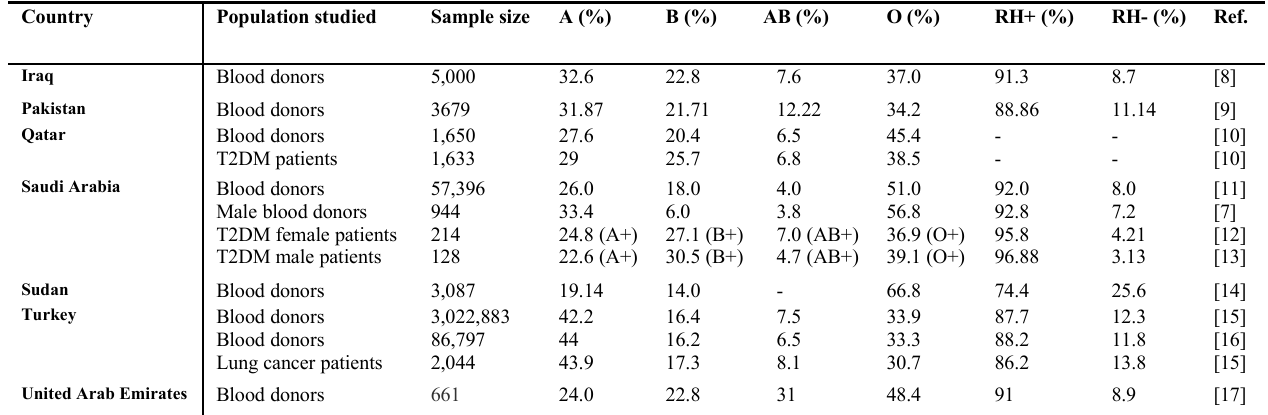
Table 1. Distribution of the ABO and RH blood groups among different populations within the MENA region.